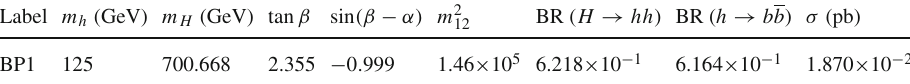
Table 1 The 2HDM-II parameters and LO cross-section of the process studied for our BP